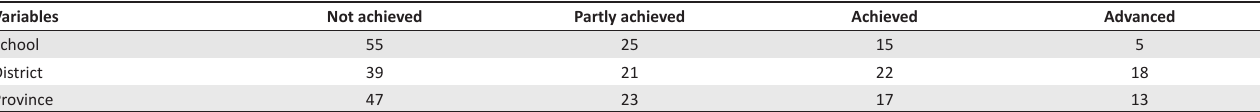
TABLE 3-A1: School performance ( % ) in mathematics by district and province. Variables